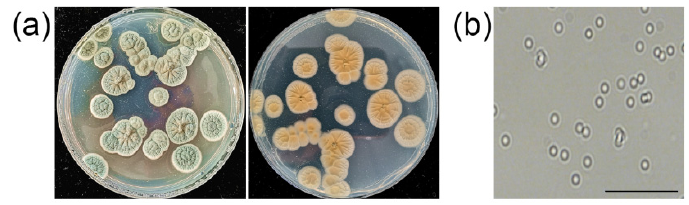
Figure 7. Morphological characteristics of the antagonistic strain ZZ1. ( a ) Colony characteristics of ZZ1 isolate. The picture was taken at 7 days after inoculation on PDA at 25 °C. ( b ) Conidia of ZZ1 isolate. Bar, 20 μ m.